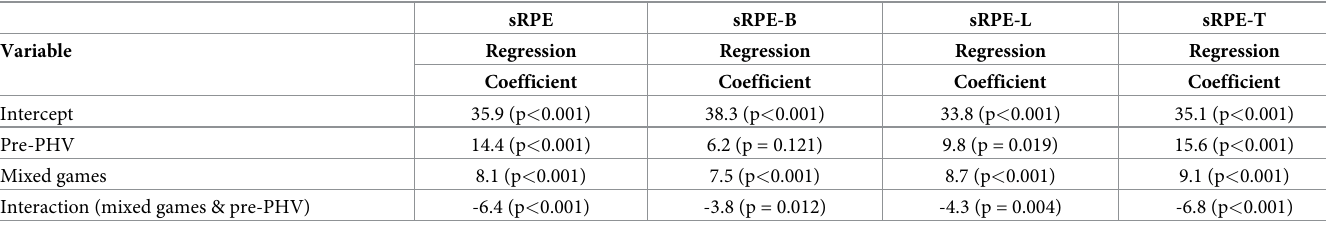
Table 2. Results of mixed effects regression models of maturation and game type effects on dRPE values.